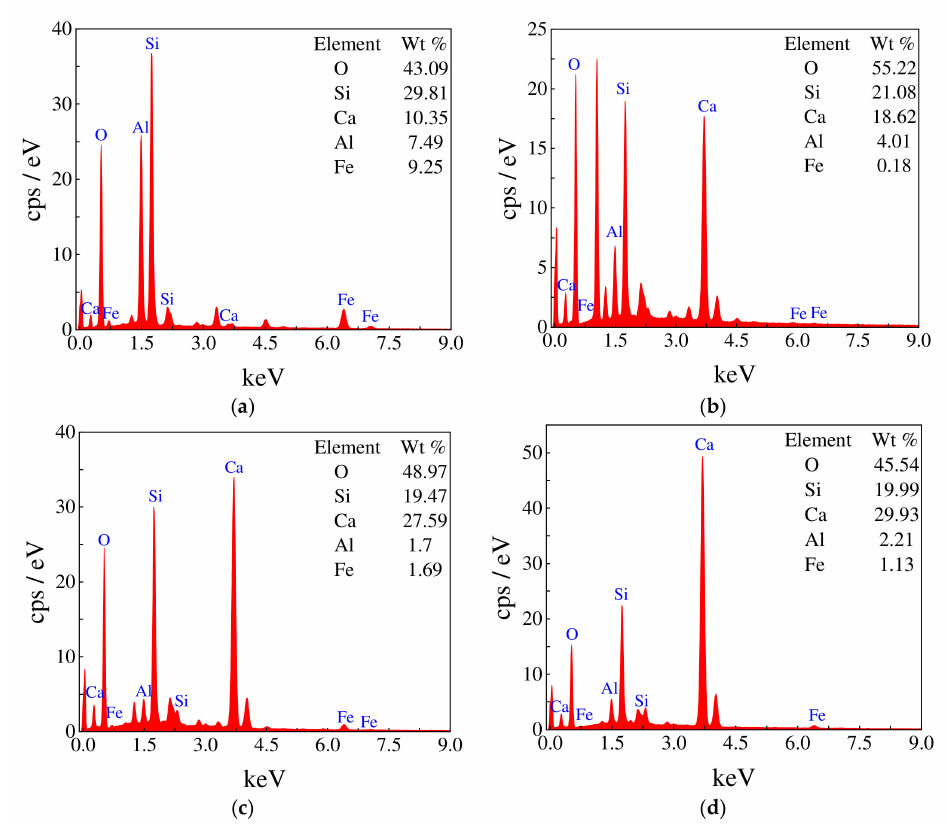
Figure 11. EDS of the reference group concrete and admixture concrete. ( a ) RC group; ( b ) Single FA; ( c ) Double mixing FA and SF; ( d ) Three admixtures of FA, SF, and